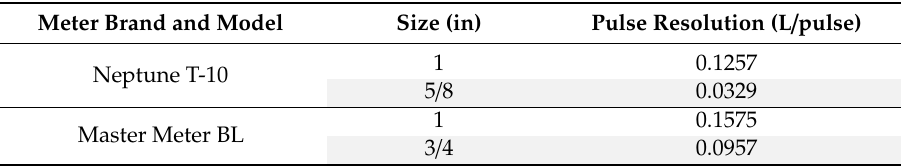
Table 6. Pulse resolution values resulting from calibration of the CIWS datalogger for the most popular meter models in Logan and Providence Cities,